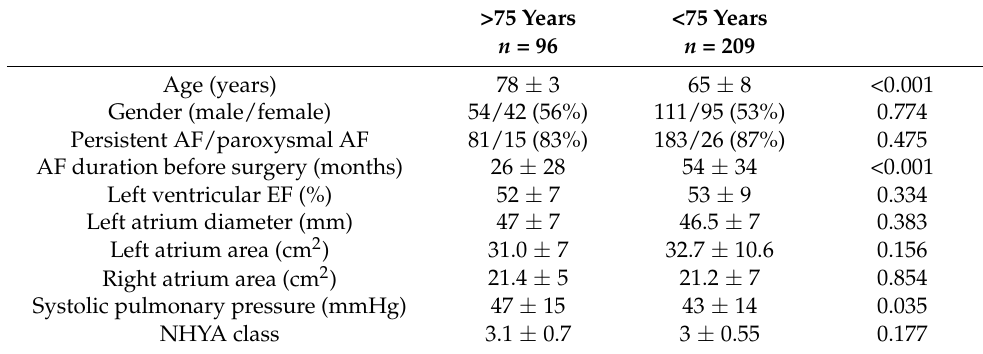
Table 1. Clinical characteristics of patients.